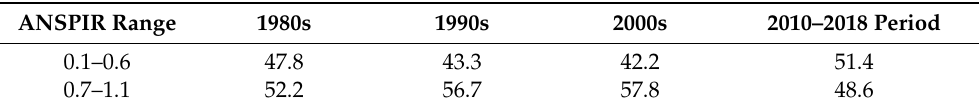
Table 3. Percentage of surface area affected by drought phenomena in each decade in relation to the ANSPIR range for the central region of Veracruz